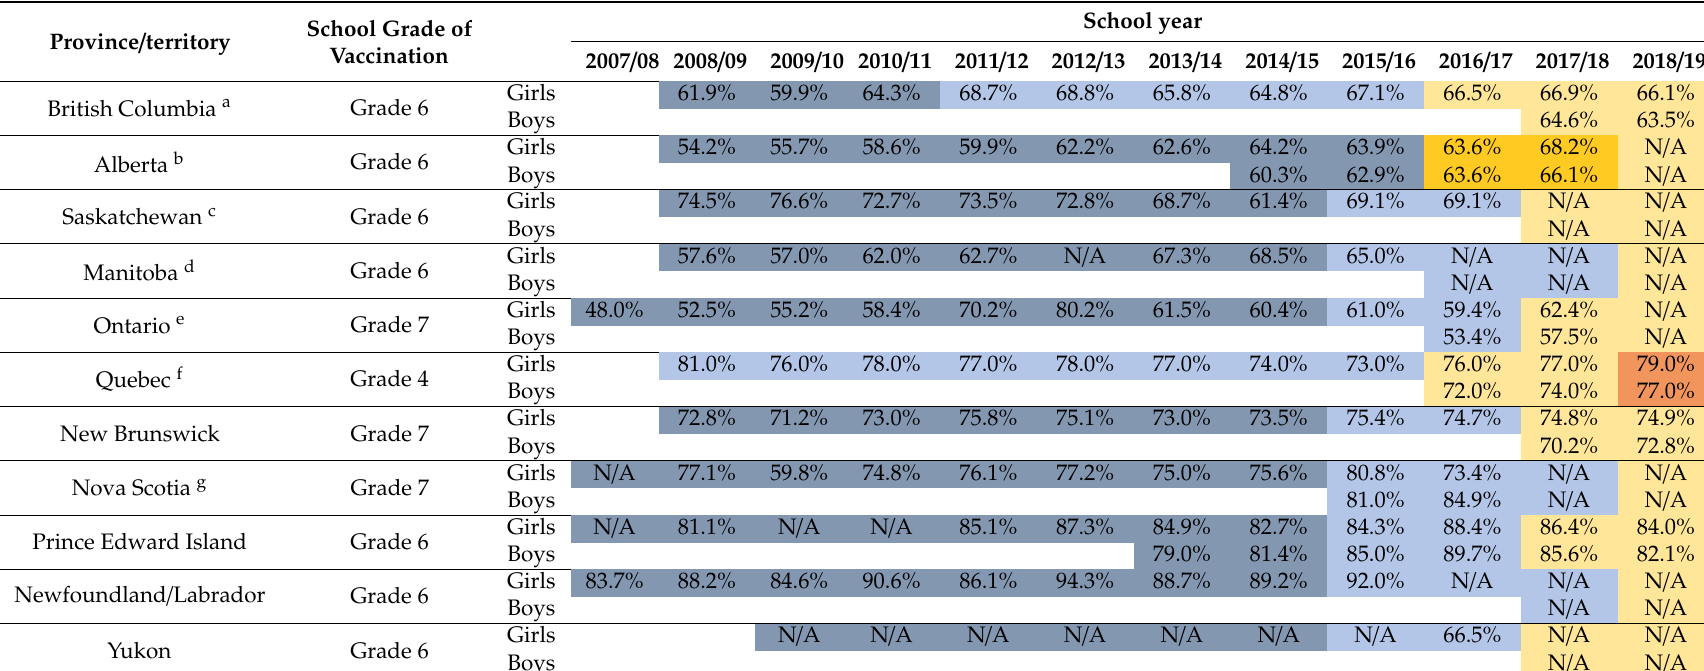
Table 1. Evolution of school-based public HPV vaccination programs and vaccination coverage